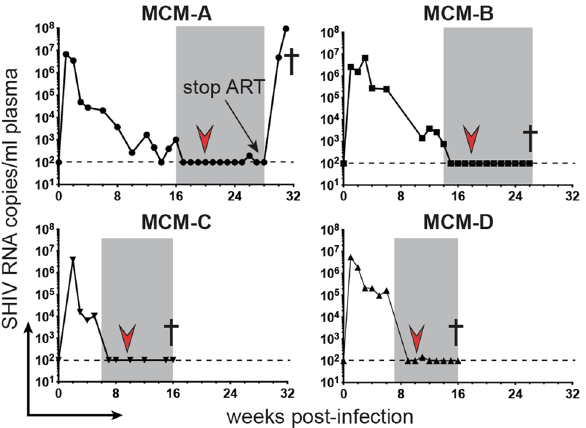
Figure 1. Plasma viral loads after SHIV162P3 infection. Longitudinal plasma viral loads for the SHIV162P3- infected MCMs, with dashed lines indicating the qRT-PCR limit of detection (100 vRNA copy Eq/mL plasma). The gray boxes signify the timing of ART, the red arrows designate allo-HSCs infusions, and † indicate